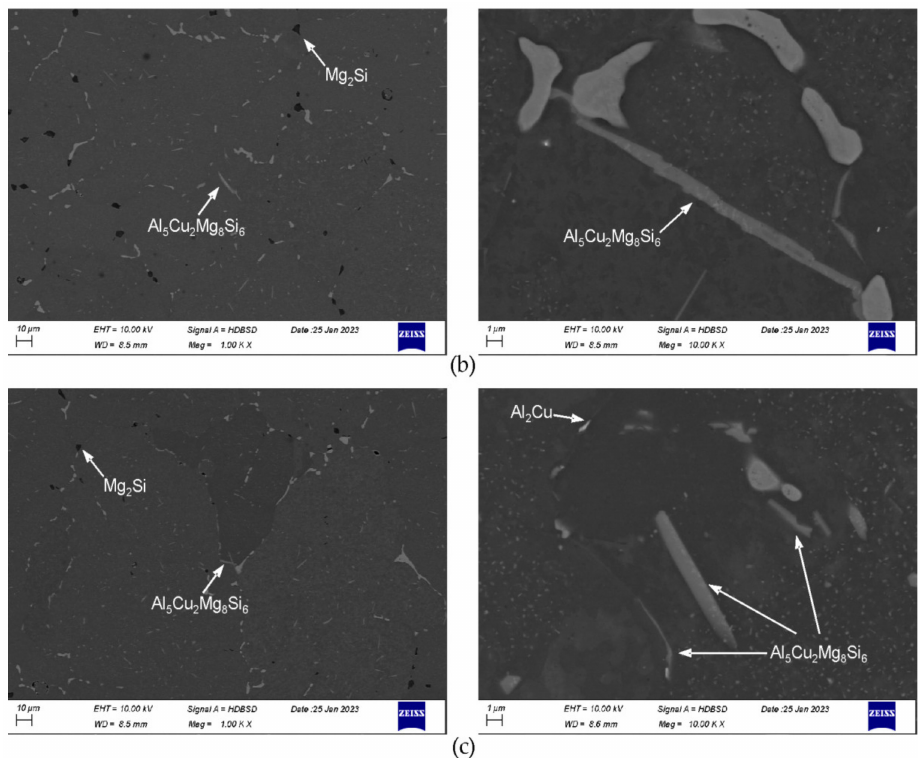
Figure 7. Microstructure after final soaking at 545 ◦ C for 8 h and cooling at: ( a ) 50 ◦ C/h; ( b ) 300 ◦ C/h, and ( c ) 500 ◦ C/h.